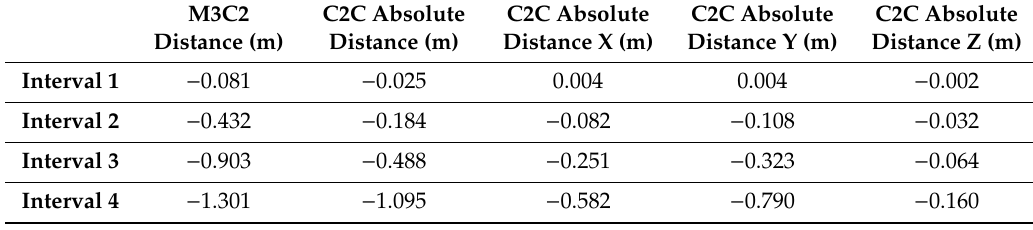
Table 2. Average erosion loss results from the Multi-Model to Model Cloud Comparison (M3C2) and Cloud-to-Cloud (C2C) algorithms for each interval.